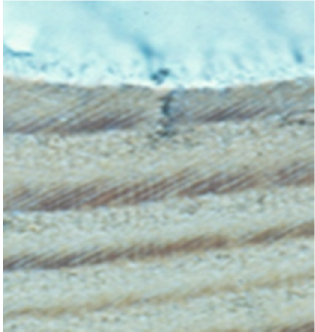
Figure 8. Cross ‐ section cut ‐ through an exposed board, showing a small crack developing due to wood Figure 8. Cross-section cut-through an exposed board, showing a small crack developing due to wood swelling as the coating fails [1]. swelling as the coating fails